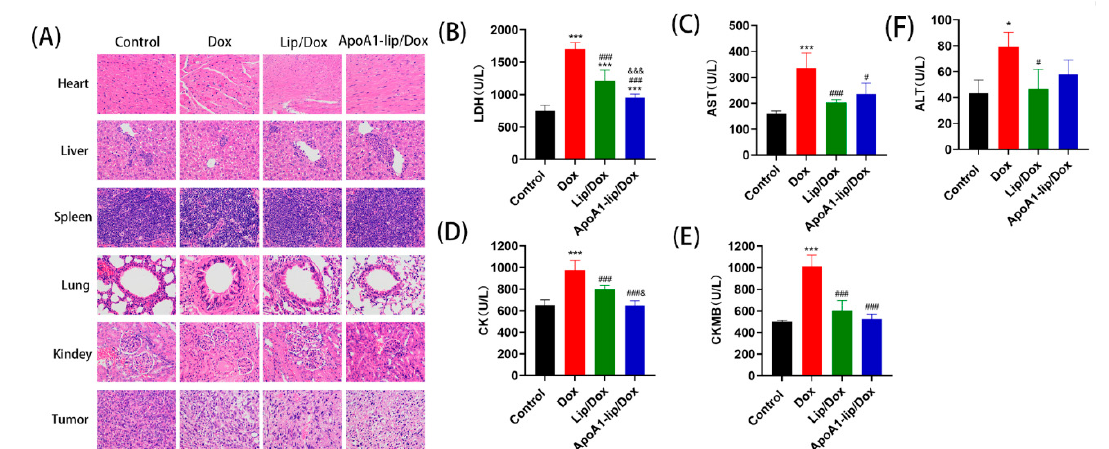
Figure 6. ( A ) H&E staining of major organs and tumor sections harvested from tumor-bearing mice on the 12th day after treated with saline, Dox, Lip/Dox, and ApoA1-lip/Dox. ( B – F ) The levels of lactate dehydrogenase (LDH), aspartate aminotransferase (AST), creatine kinase (CK), creatine kinase/MB isoenzyme (CK-MB) and alanine aminotransferase (ALT) after intravenous administration with different Dox formulations in 4T1-bearing mice. ( n = 5, mean ± SD, * p < 0.05, *** p < 0.01, compared with saline group, # p < 0.05, ### p < 0.01, compared with Dox, & p < 0.05, &&& p < 0.01, compared with Lip/Dox.